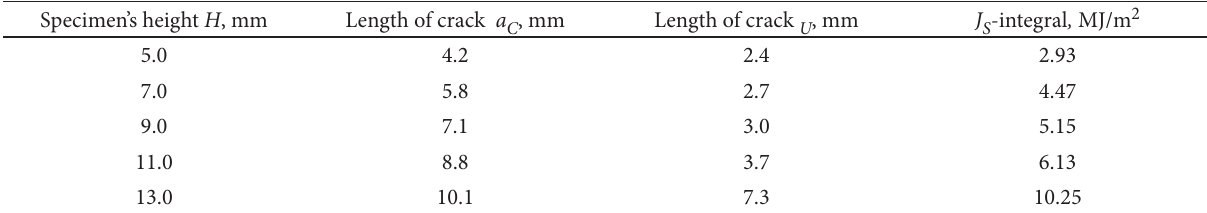
Table 4. Values of the length of cracks and the calculated relative integral Specimen’s height H ,